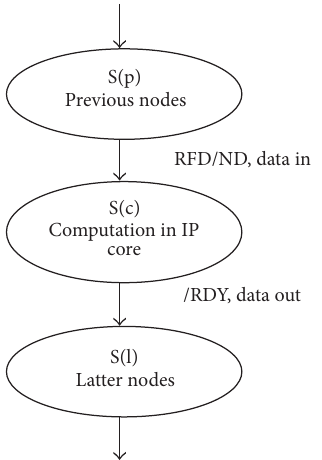
Figure 6: A part of the state machine for datapath in the presence of an IP